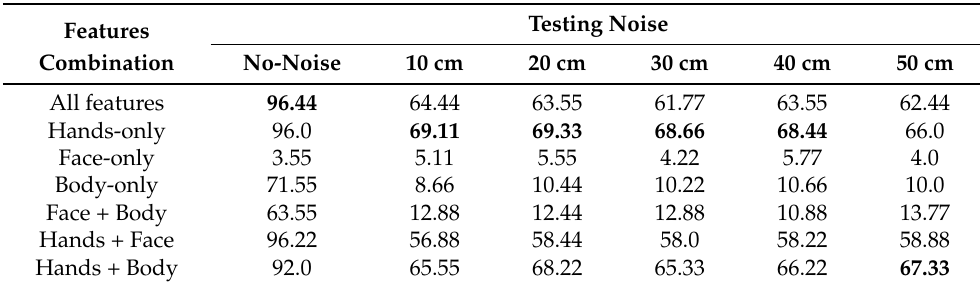
Table 8. Model accuracy when varying the input features. Every row reports the results of a model training with a specific set of features. For example, the row names All features used hands, body, and face keypoints. The best result on each column is highlighted in bold.